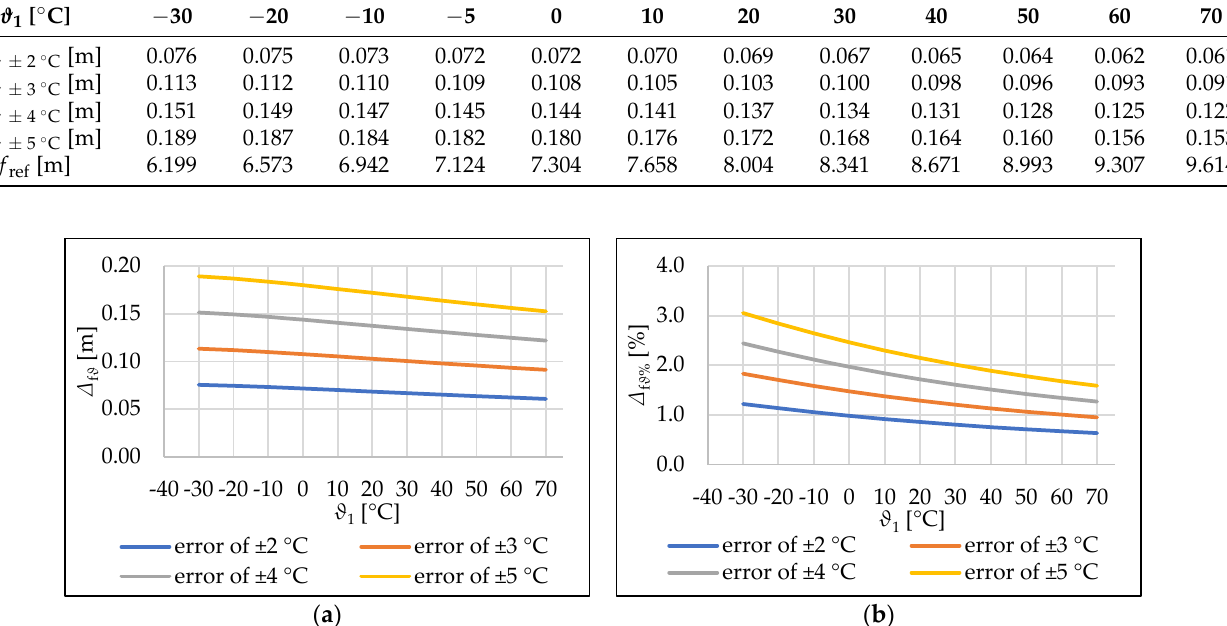
Figure 5. Decrease of the sag deviations depending on the temperature ϑ 1 from the sag-tension table: ( a ) Absolute sag deviations; ( b ) percentage sag deviations.